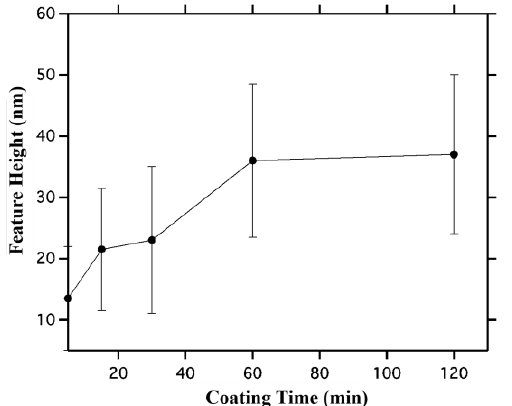
Figure 5. Average height of assembled nanoparticle features as a function of coating time. Error bars are 1 sigma standard deviation taken by averaging multiple linescans